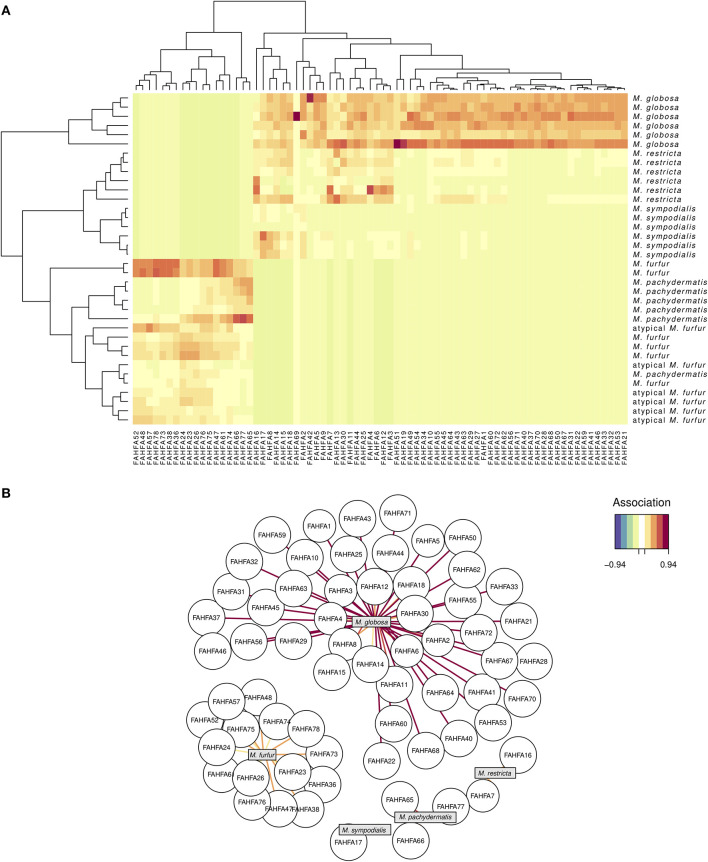
FAHFA lipid signature in five species of Malassezia and a putative M. furfur (atypical M. furfur) strain, six biological replicates were analyzed. A sPLS-DA (see Figure 2) barely reduced the dimensionality of 77–74 FAHFA lipids, which successfully discriminated among M. globosa, M. restricta, and M. sympodialis but not among the other studied lineages. See Figure 2 for explanation of the corresponding visualizations: the clustering heat map (above, A), and the correlation network (below, B).